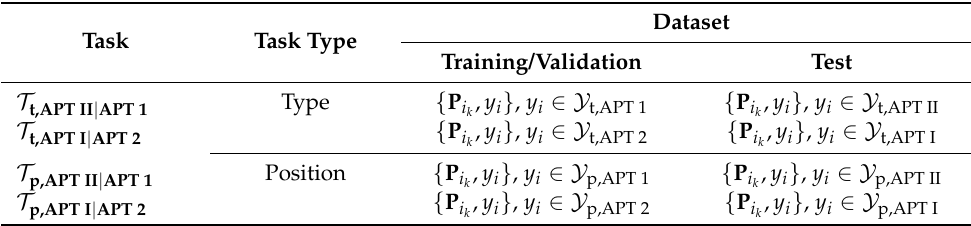
Table 2. Summary of knowledge transfer tasks described in Section